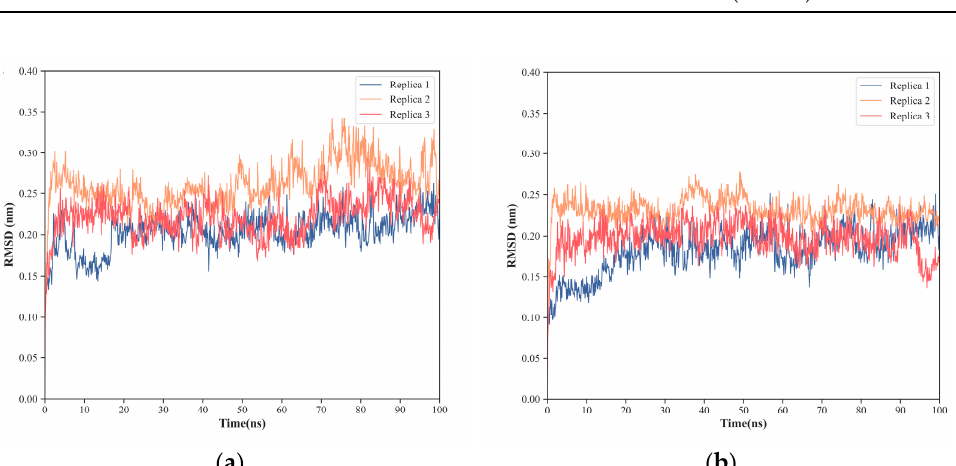
Figure 8. C α atoms RMSD for the residues in the interface of the complex between NS1 and PI3K, considering the residues from both NS1 and PI3K ( a ) or just the residues from NS1 ( b ).